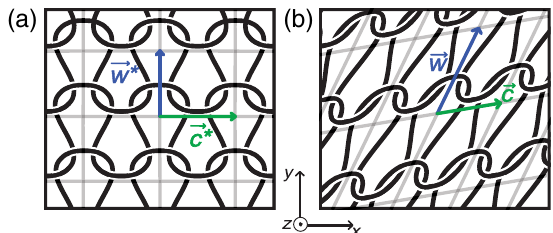
FIG. 3. Schematic representation of the absolute reference configuration and a deformed state of the fabric. A geometrical representation of the stockinette stitch network consists in joining the geometric centers of neighboring stitches along the wale and course directions. This defines a four-degree planar graph (light gray lines) that is uniquely determined by the edge vectors along the course and wale directions. (a) Absolute reference state of the ⃗ c (cid:2) ⃗ w (cid:2) fabric: The vectors and are orthogonal and identical for all cells. (b) Deformed state of the fabric: Directions and norms of the vector fields ⃗ c and ⃗ w vary across the